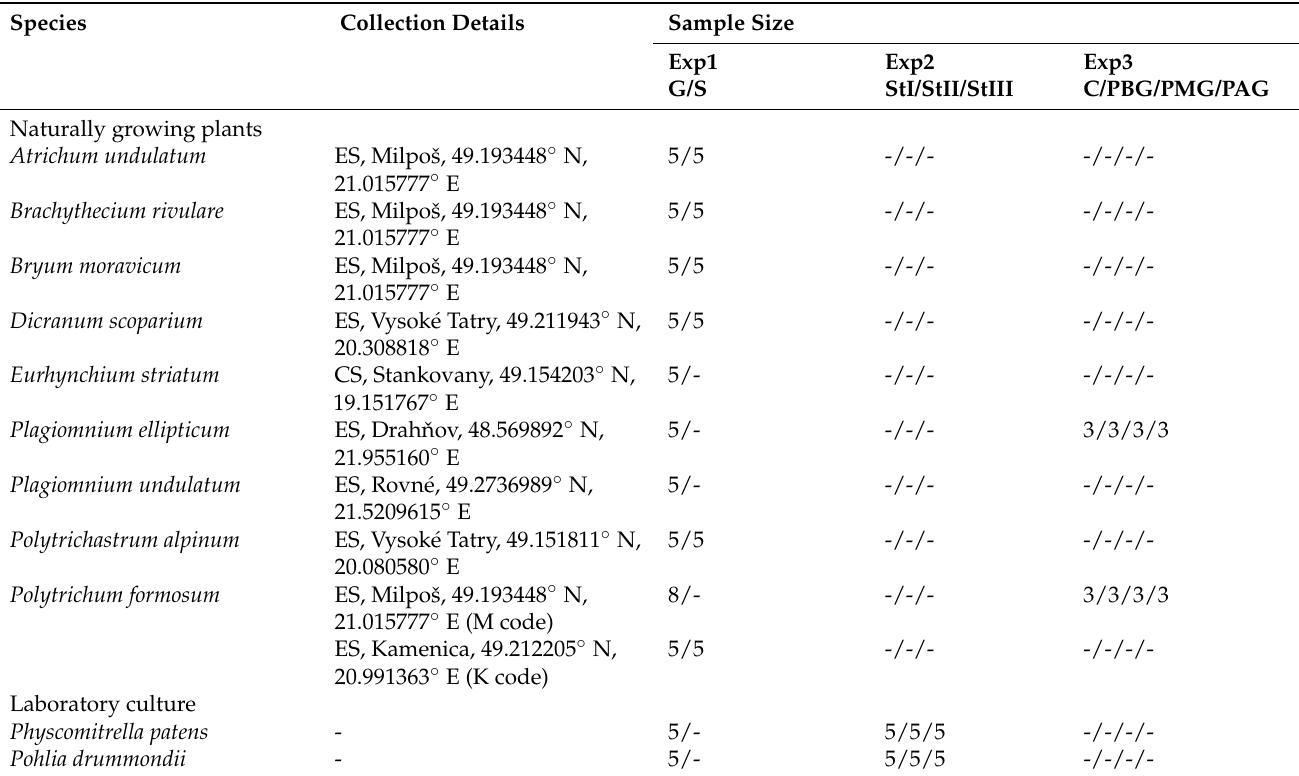
Table 1. Summary of plant material used in the present